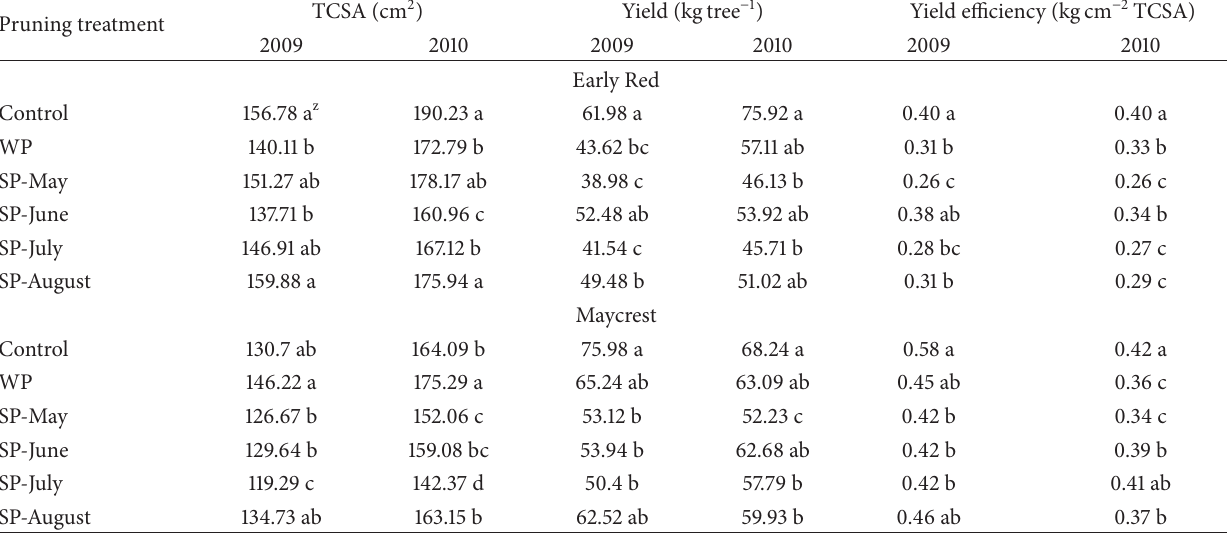
Table 2: The effects of summer and winter pruning time on TCSA, yield, and yield efficiency of “Early Red” and “Maycrest” peach cultivars. Pruning